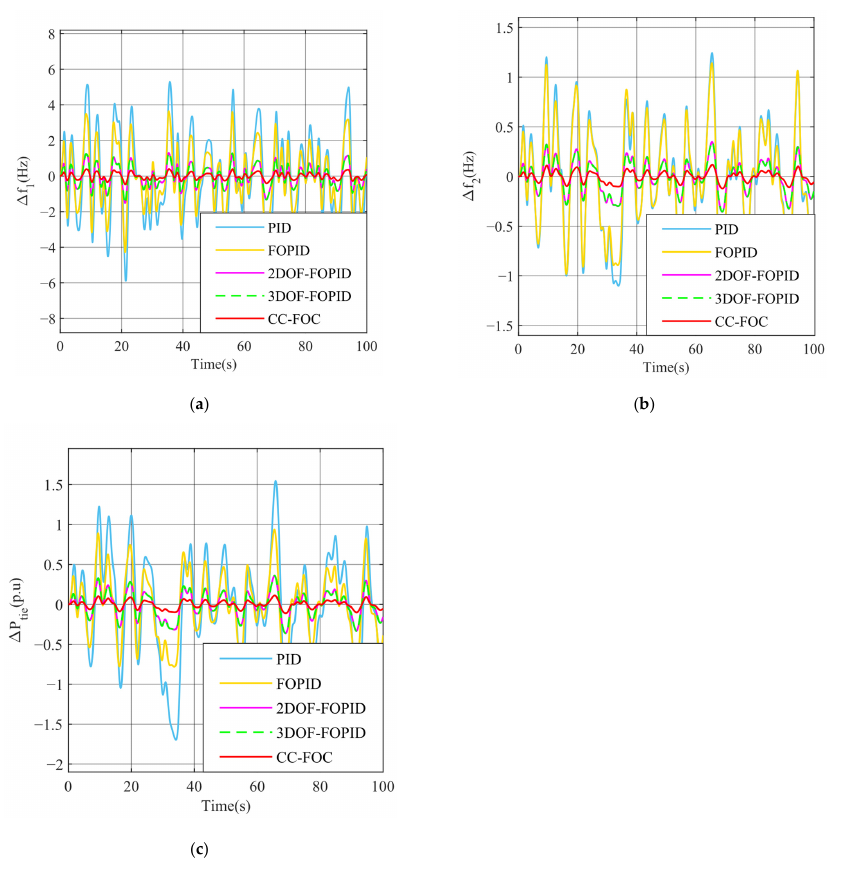
Figure 9. Dynamic performance of the system under random wind speed fluctuations. ( a ) Δ 1 f , ( b ) Δ , and ( c ) Δ ∆ P 2 f tie P . ( b ) ∆ f 2 , and ( c ) tie